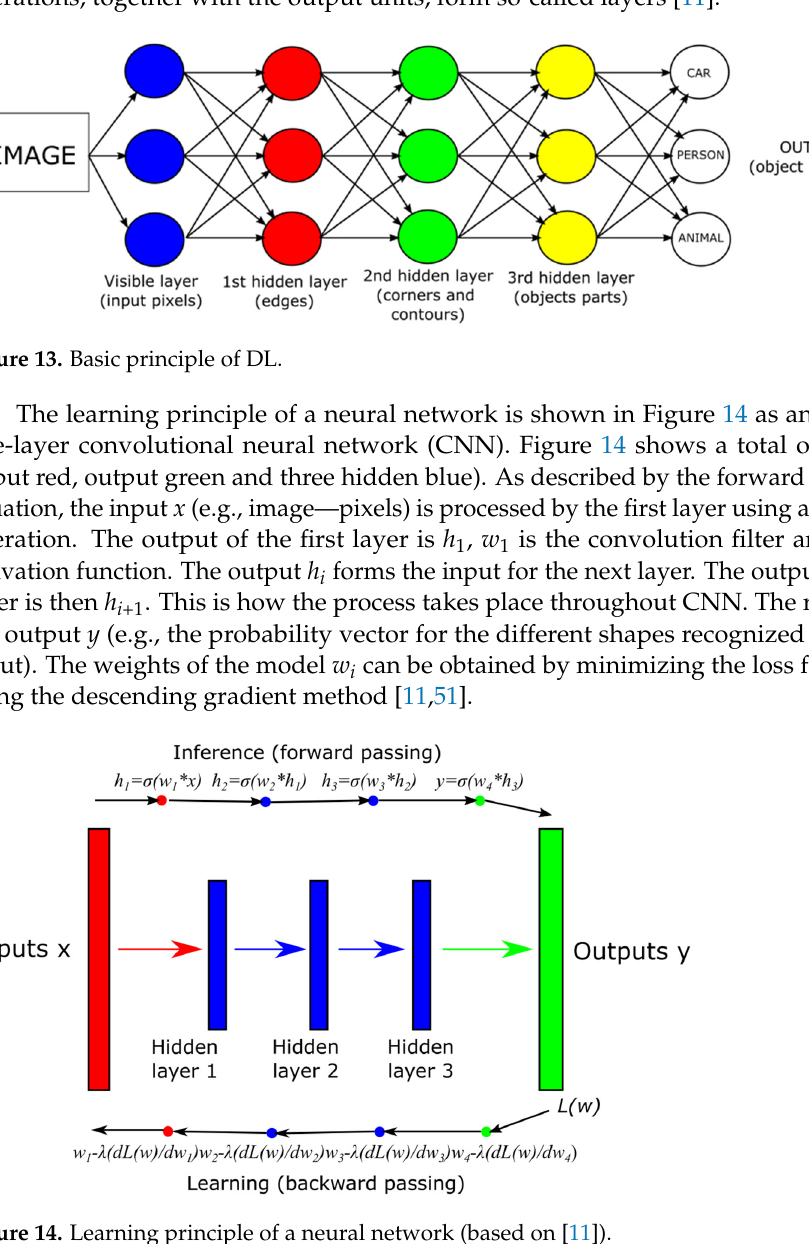
Figure 14. Learning principle of a neural network (based on [11]).